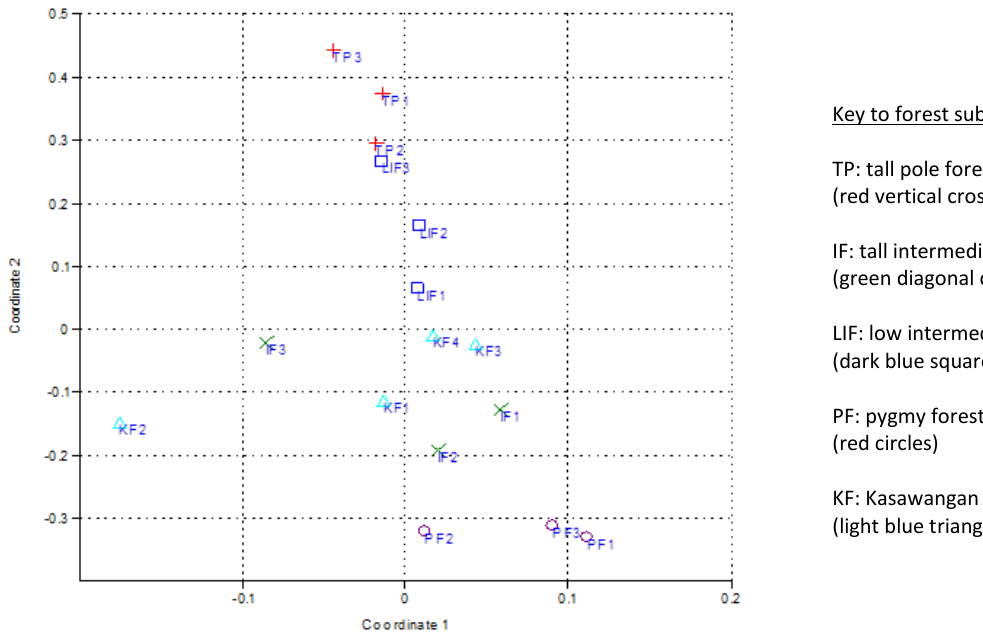
Figure A1. Non-metric multidimensional scaling (NMDS) results comparing forest subtype characteristics (tree diameter, tree height, number of species) with peat properties (listed in Table A1). The letters in each data-point label refer to a forest subtype (see key) and these are appended with the plot number.